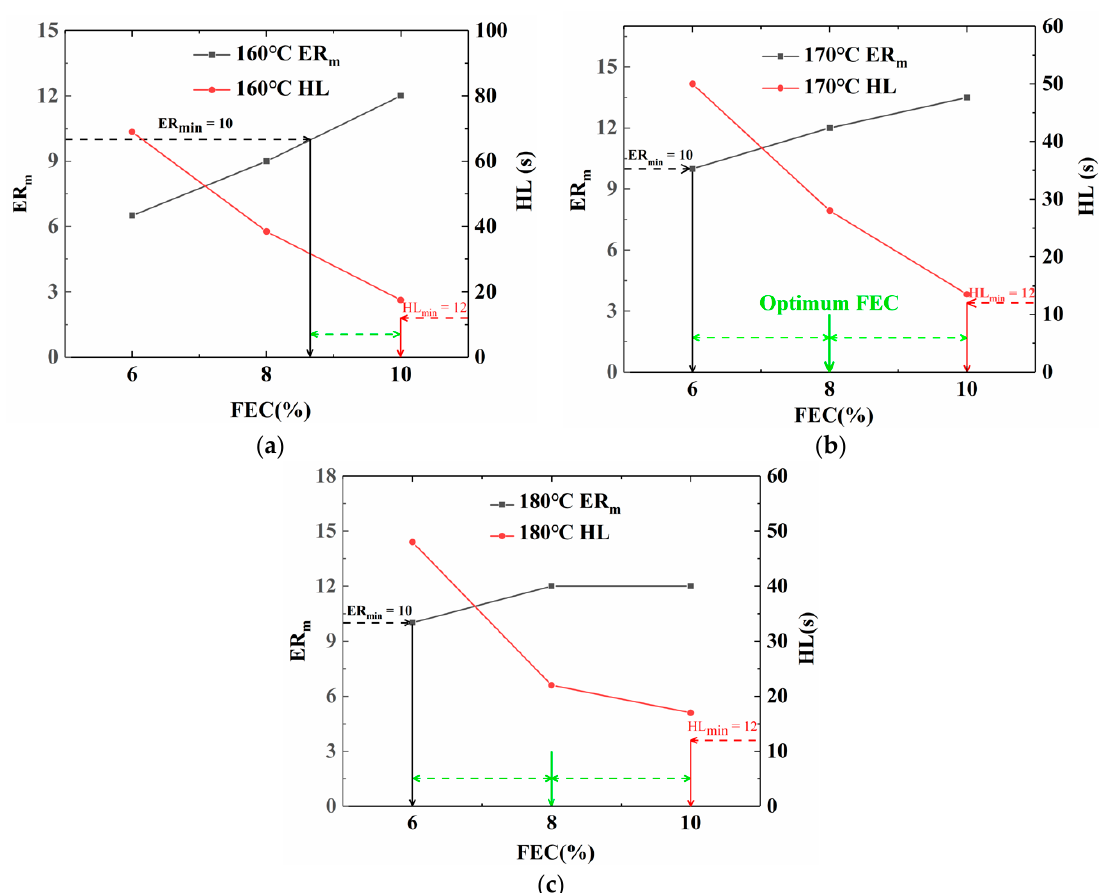
Figure 1. The ERm and HL variations with FEC at different temperatures: ( a ) 160 °C; ( b ) 170 °C; ( c ) 180 °C.